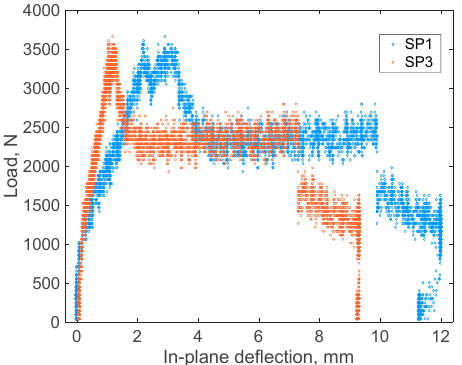
Figure 4. In-plane displacements of Wall 1.